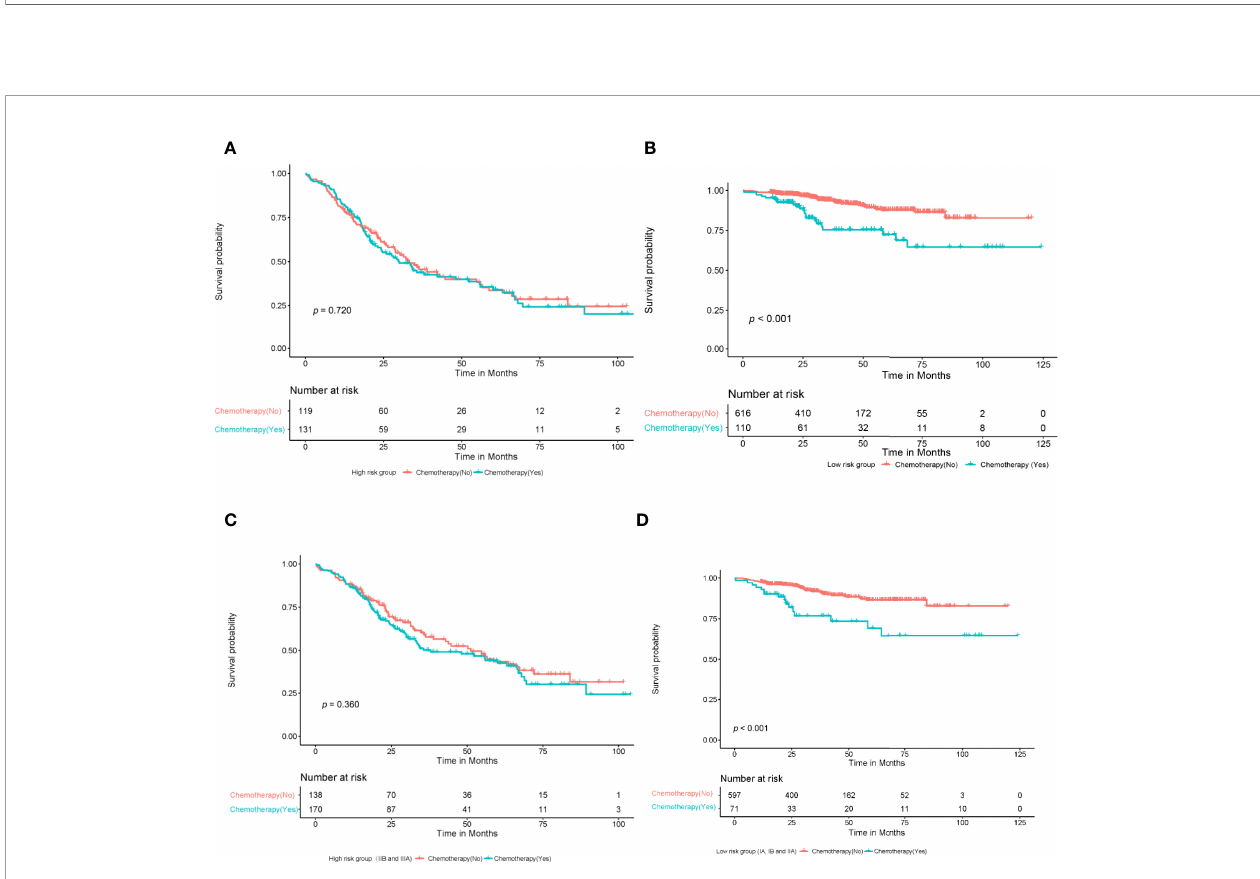
FIGURE 8 | A Kaplan-meier analysis and log-rank test were performed to determine the survival rate of patients at high and low risk who with or without adjuvant chemotherapy. The results showed that there was no signi fi cant difference in survival rate among high-risk patients who with or without chemotherapy (A) ( P =0.720, log-rank test); Patients in the low-risk group who received chemotherapy had a lower survival rate than those who did not (B) ( P <0.001, log-rank test). There was no signi fi cant difference in survival rate among high-risk patients (IIB, IIIA) who with or without chemotherapy (C) ( P =0.360, log-rank test); Patients in the low-risk group (IA,IB, IIA) who received chemotherapy had a lower survival rate than those who did not (D) ( P <0.001, log-rank test).